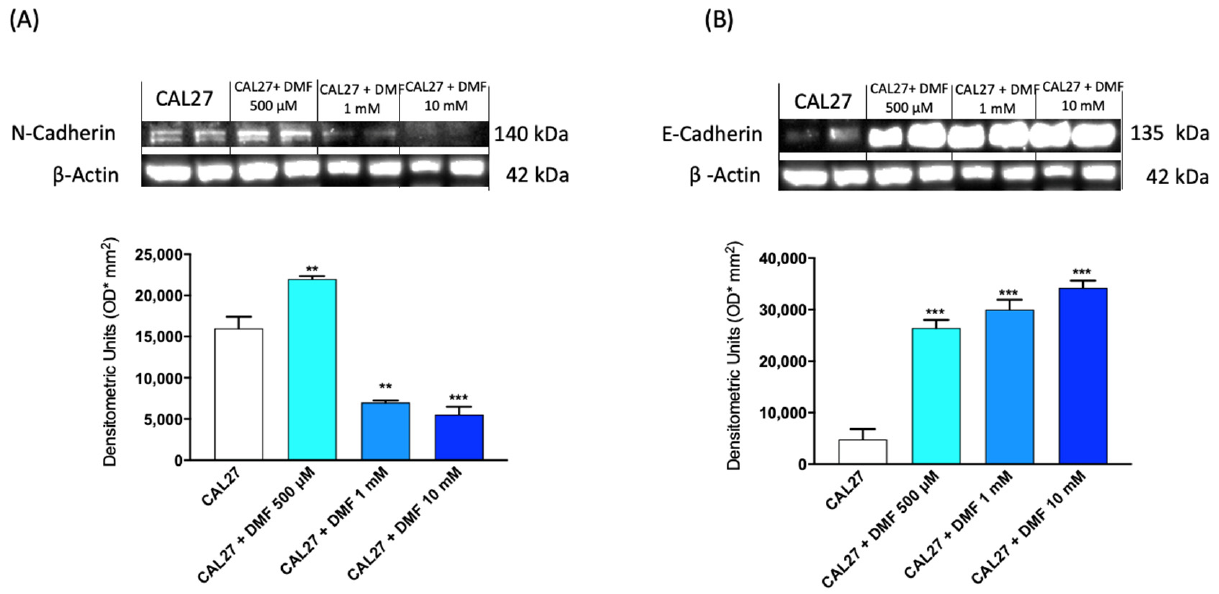
Figure 4. Effect of DMF on N-Cadherin and E-Cadherin expression in CAL27 cells. The blots revealed a significant decrease of N-Cadherin expression following DMF treatment at the concentration of 1 mM and 10 mM ( A ). DMF was also able to significant increase the expression of E-Cadherin at the concentration of 500 µ M, 1 mM and 10 mM ( B ). ( A , B ) ** p < 0.01 vs. CAL27, *** p < 0.001 vs. CAL27.